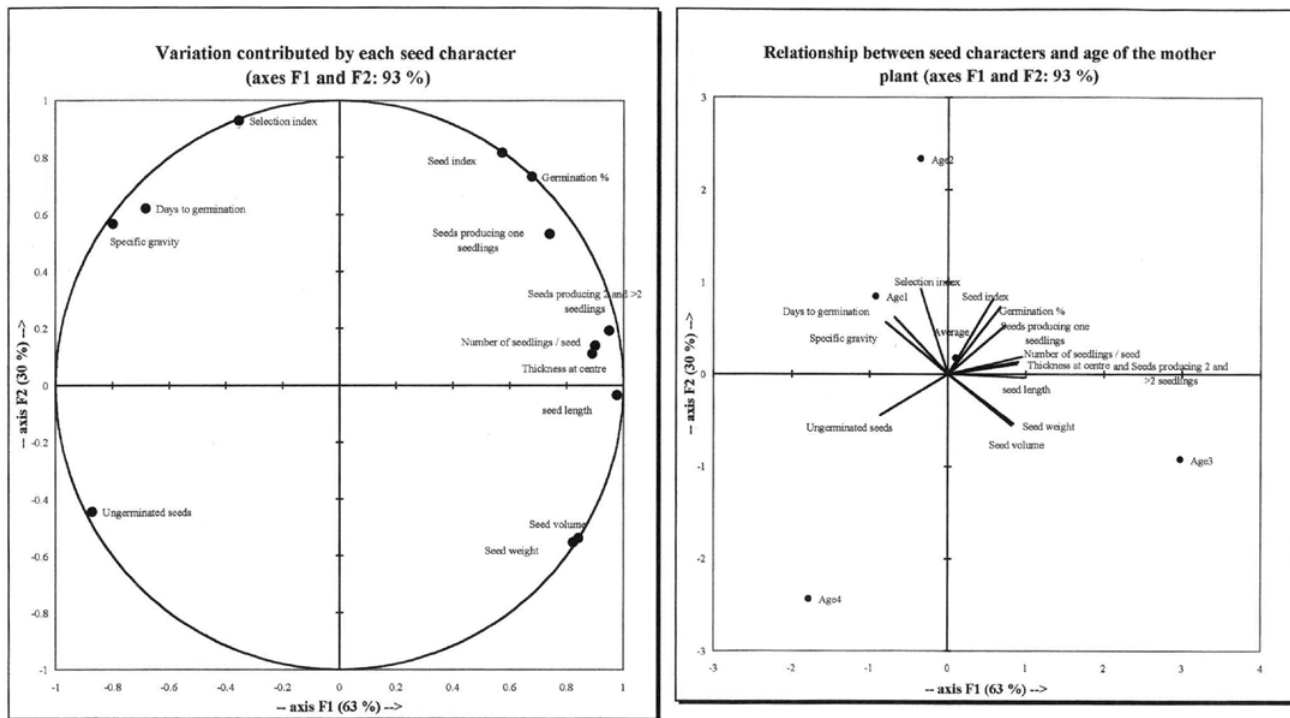
Fig. 3 - Plot showing the percentage of variation contributed by each seed character and the relationship between age of the mother plant and seed characters in mangosteen ( Garcinia mangostana L.).